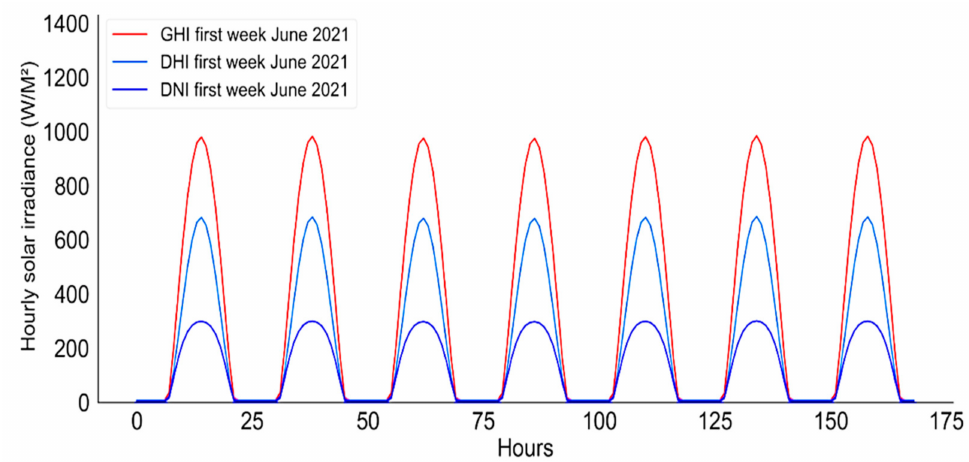
Figure 12. Hourly intervals historical performances of the GHI, DHI, and